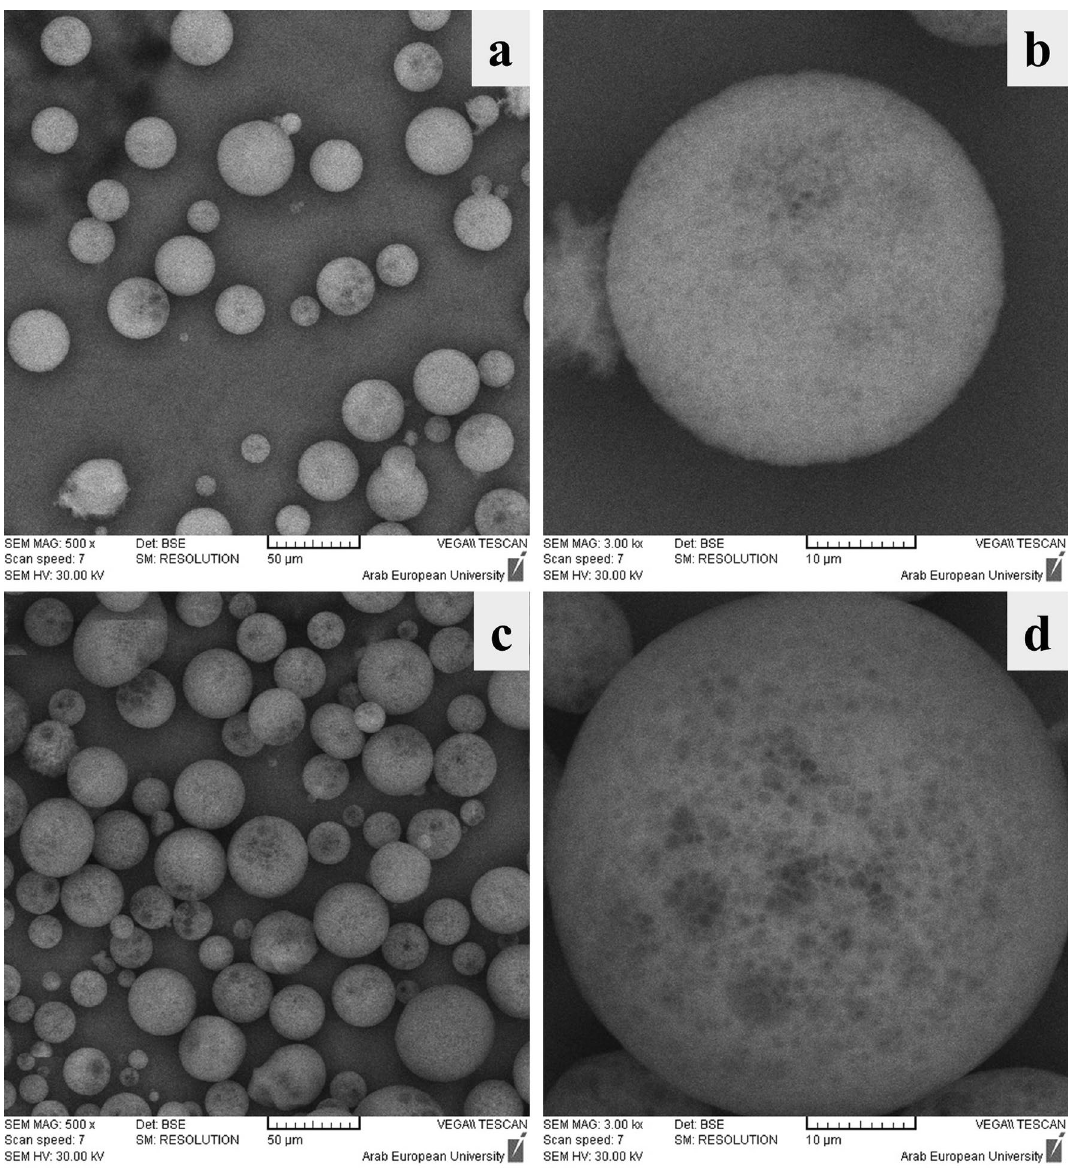
Figure 2. SEM images of ( a ) C5 formulation, 500x, ( b ) C5 formulation, 3000x, ( c ) C6 formulation, 500x, ( d ) C6 formulation, 3000x.